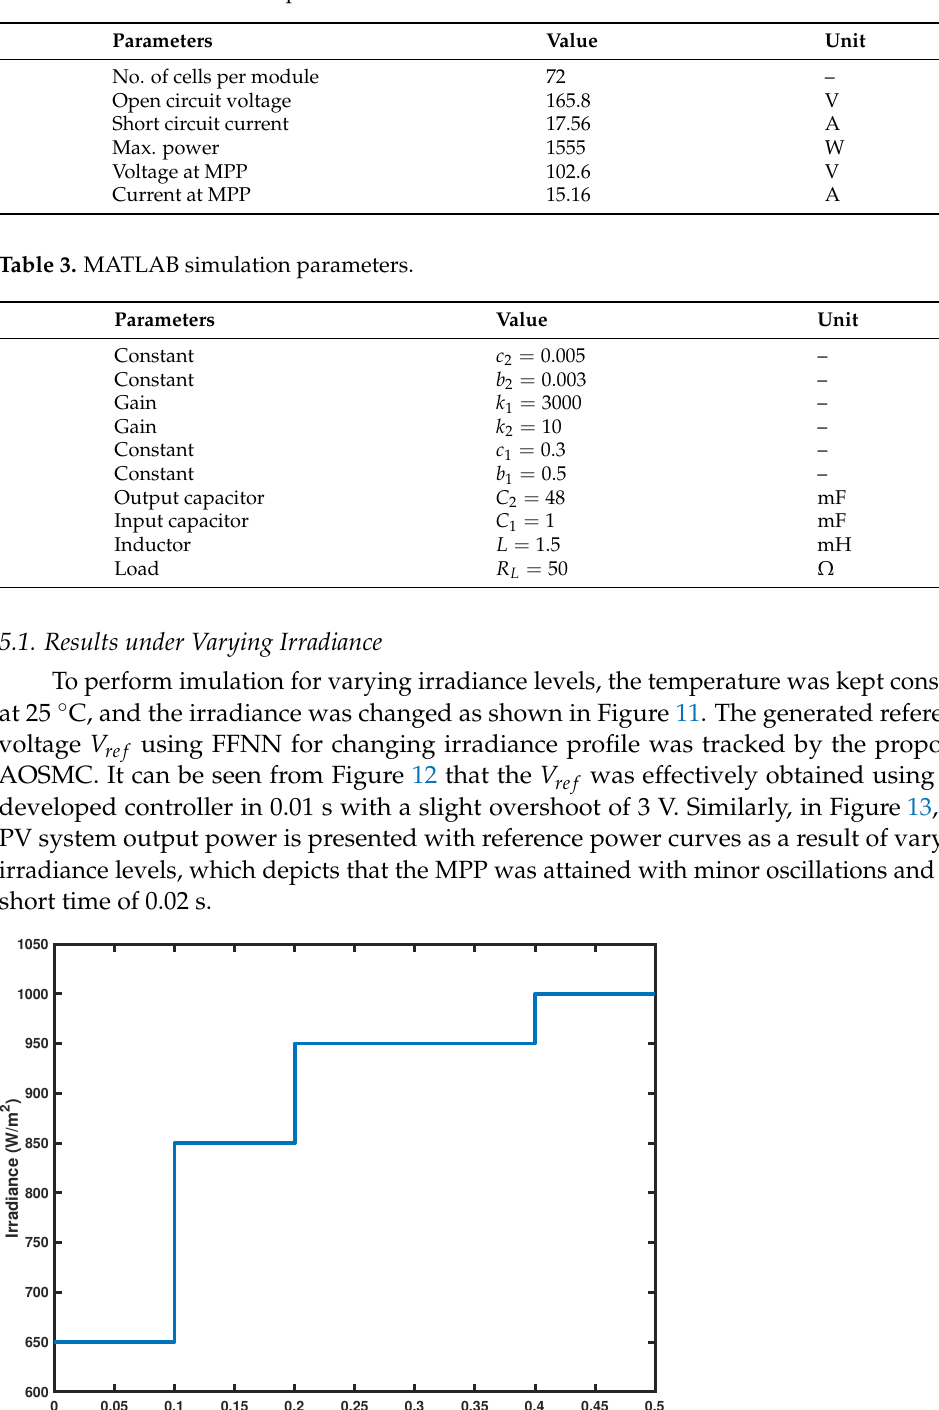
Table 2. Parameters of solar panels.